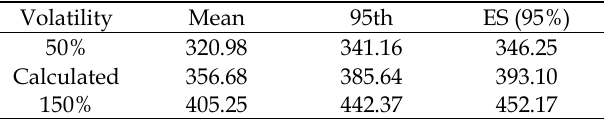
Sensitivity Annual Costs to Tobit volatility 2019 (millions